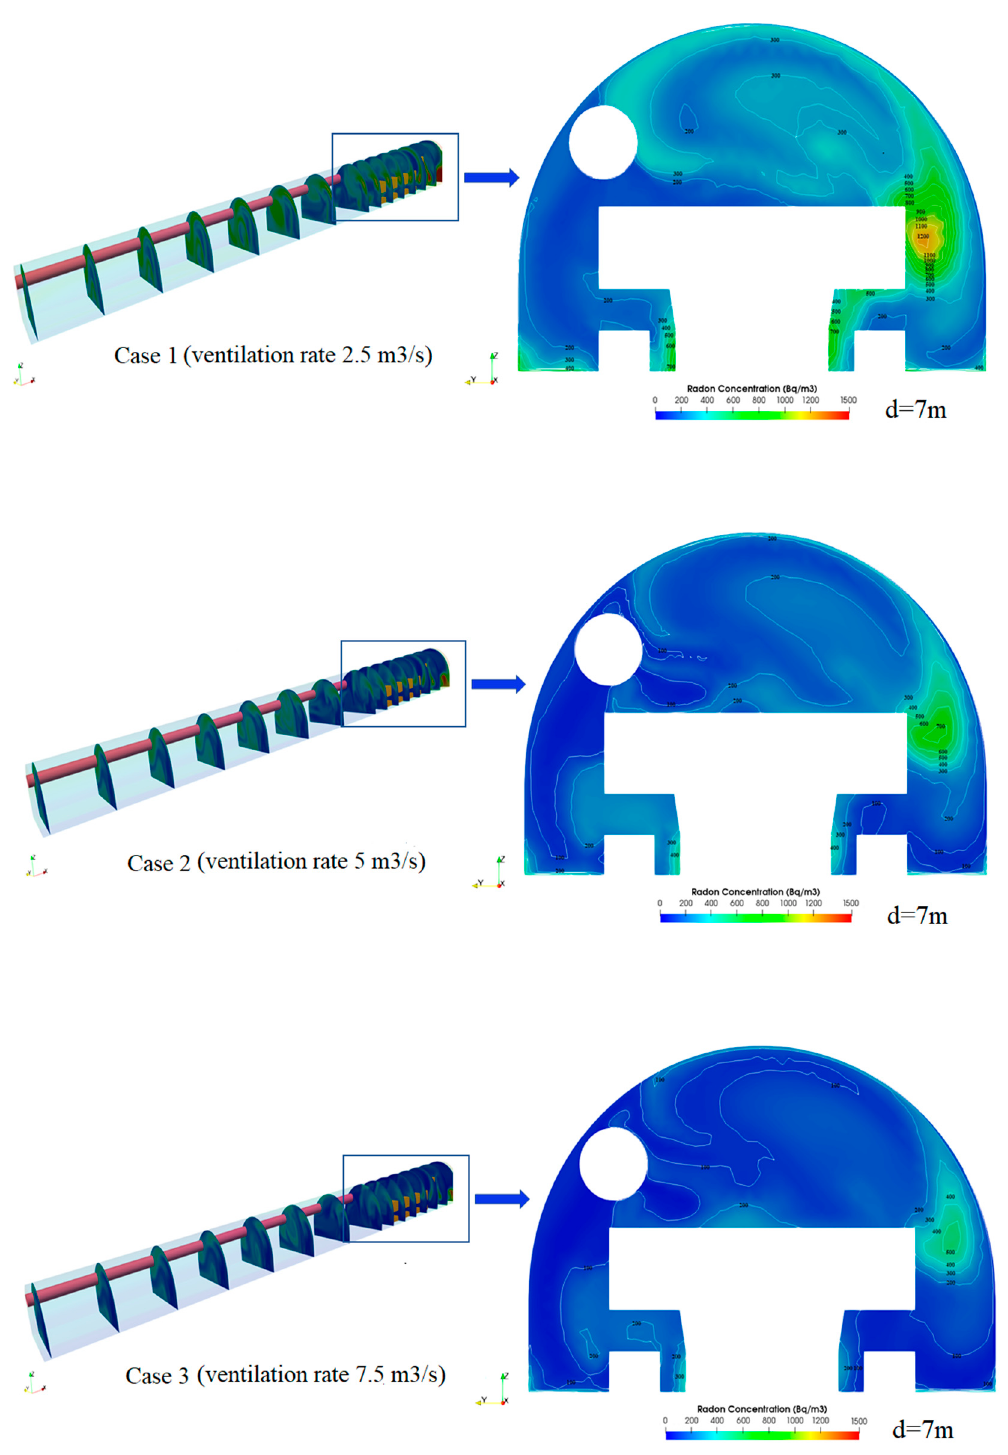
Figure 10. Vertical cross-sections of radon concentration distribution at different locations from the heading